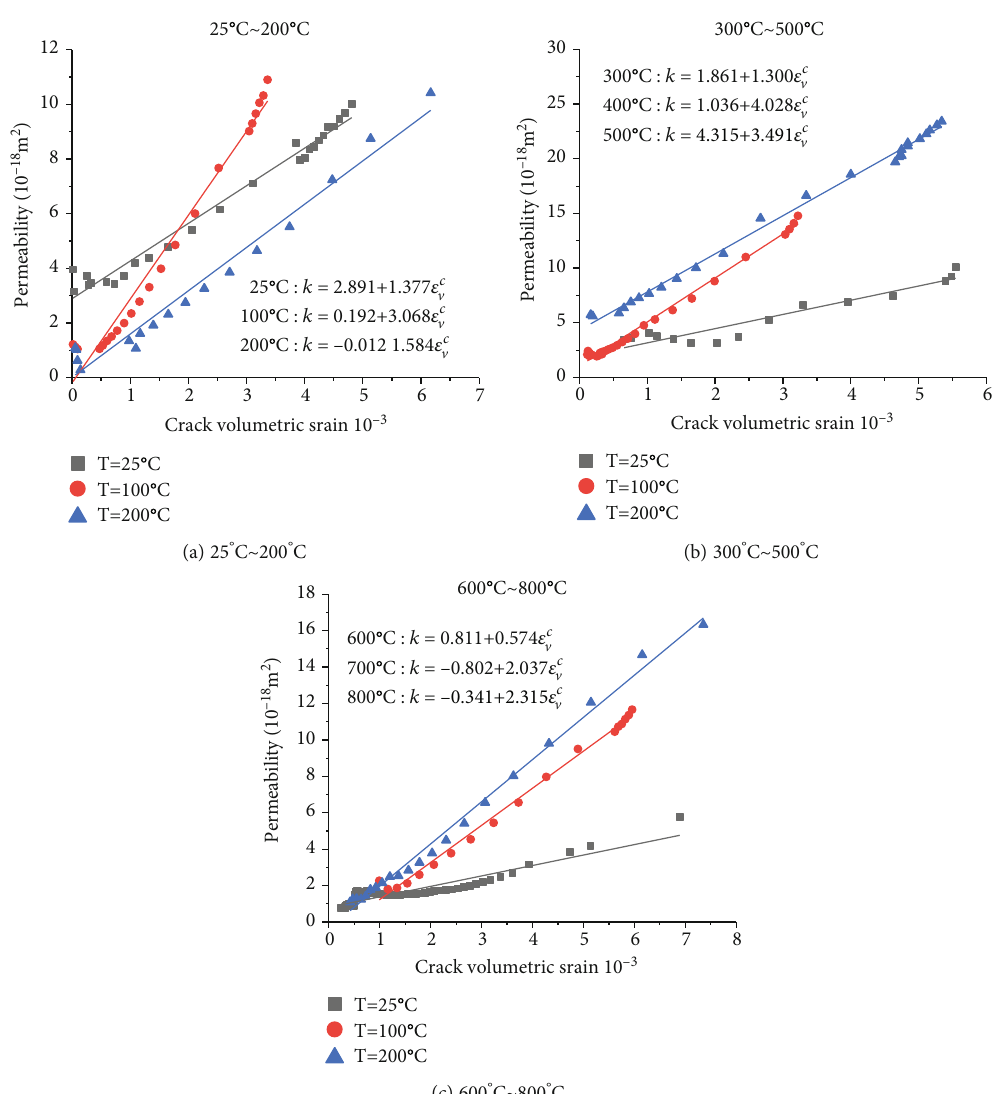
Figure 11: Curves of the crack volumetric strain and permeability considering di ff erent heated